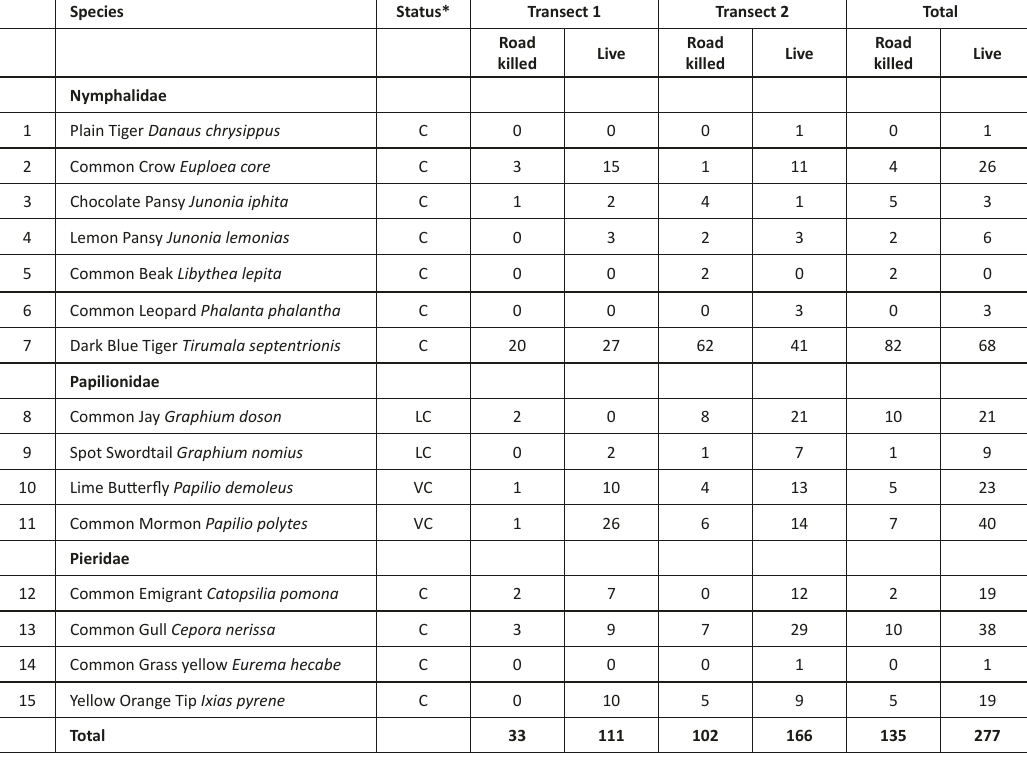
Table 1. Butterfly road kills and encounter rate (individuals/500m) in different